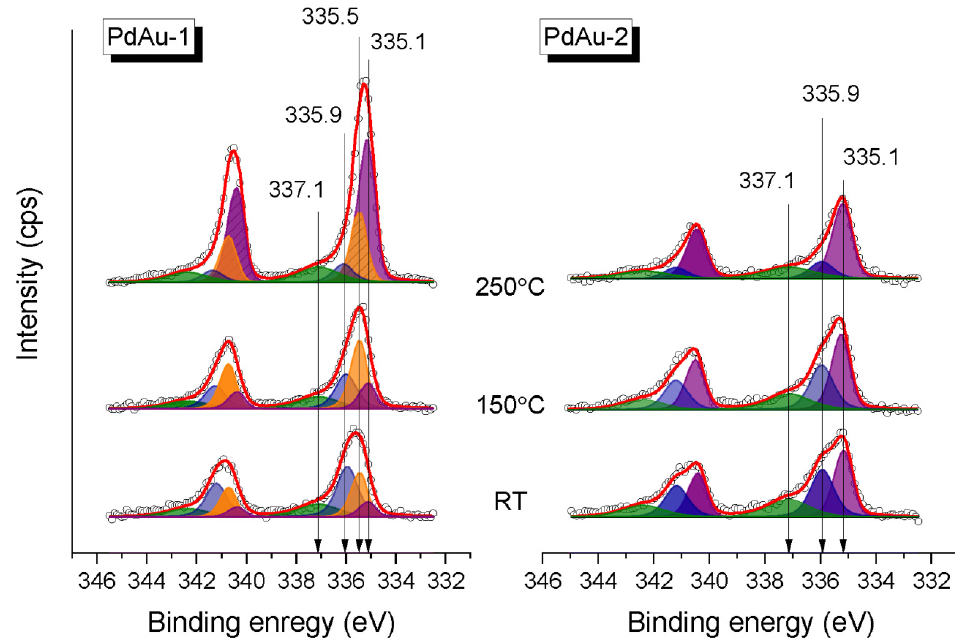
Figure 4. Pd3d XP spectra measured for PdAu-1 and PdAu-2 samples in the carbon monoxide: oxygen mixtures (CO/O 2 = 2:1, P total = 0.25 mbar) at RT, 150 °C and 250 °C. The kinetic energy of photoelectrons was 300 eV (the depth of analysis was 1.8 nm).